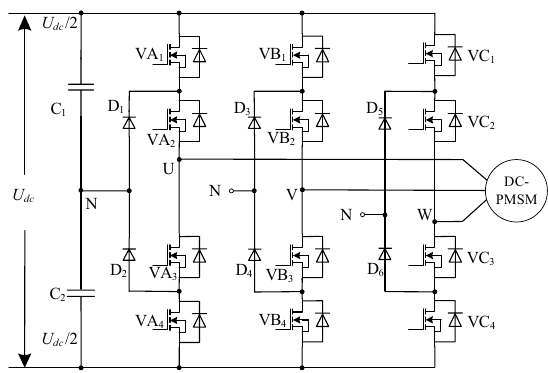
Figure 38 Three-level midpoint-clamped inverter circuit